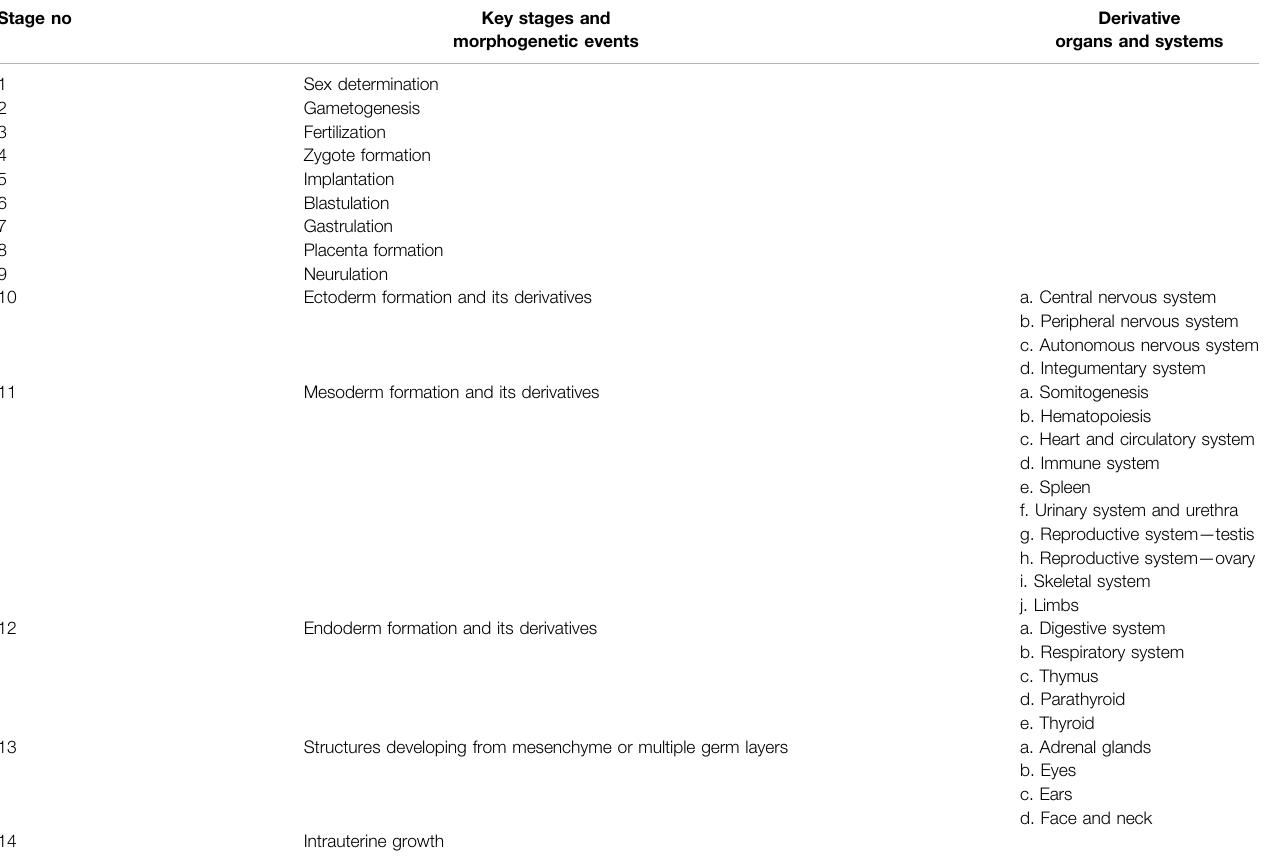
TABLE 1 | Key stages, morphogenetics events and derivatives of human reproductive biology and embryo-foetal development. Stage no Key stages and morphogenetic